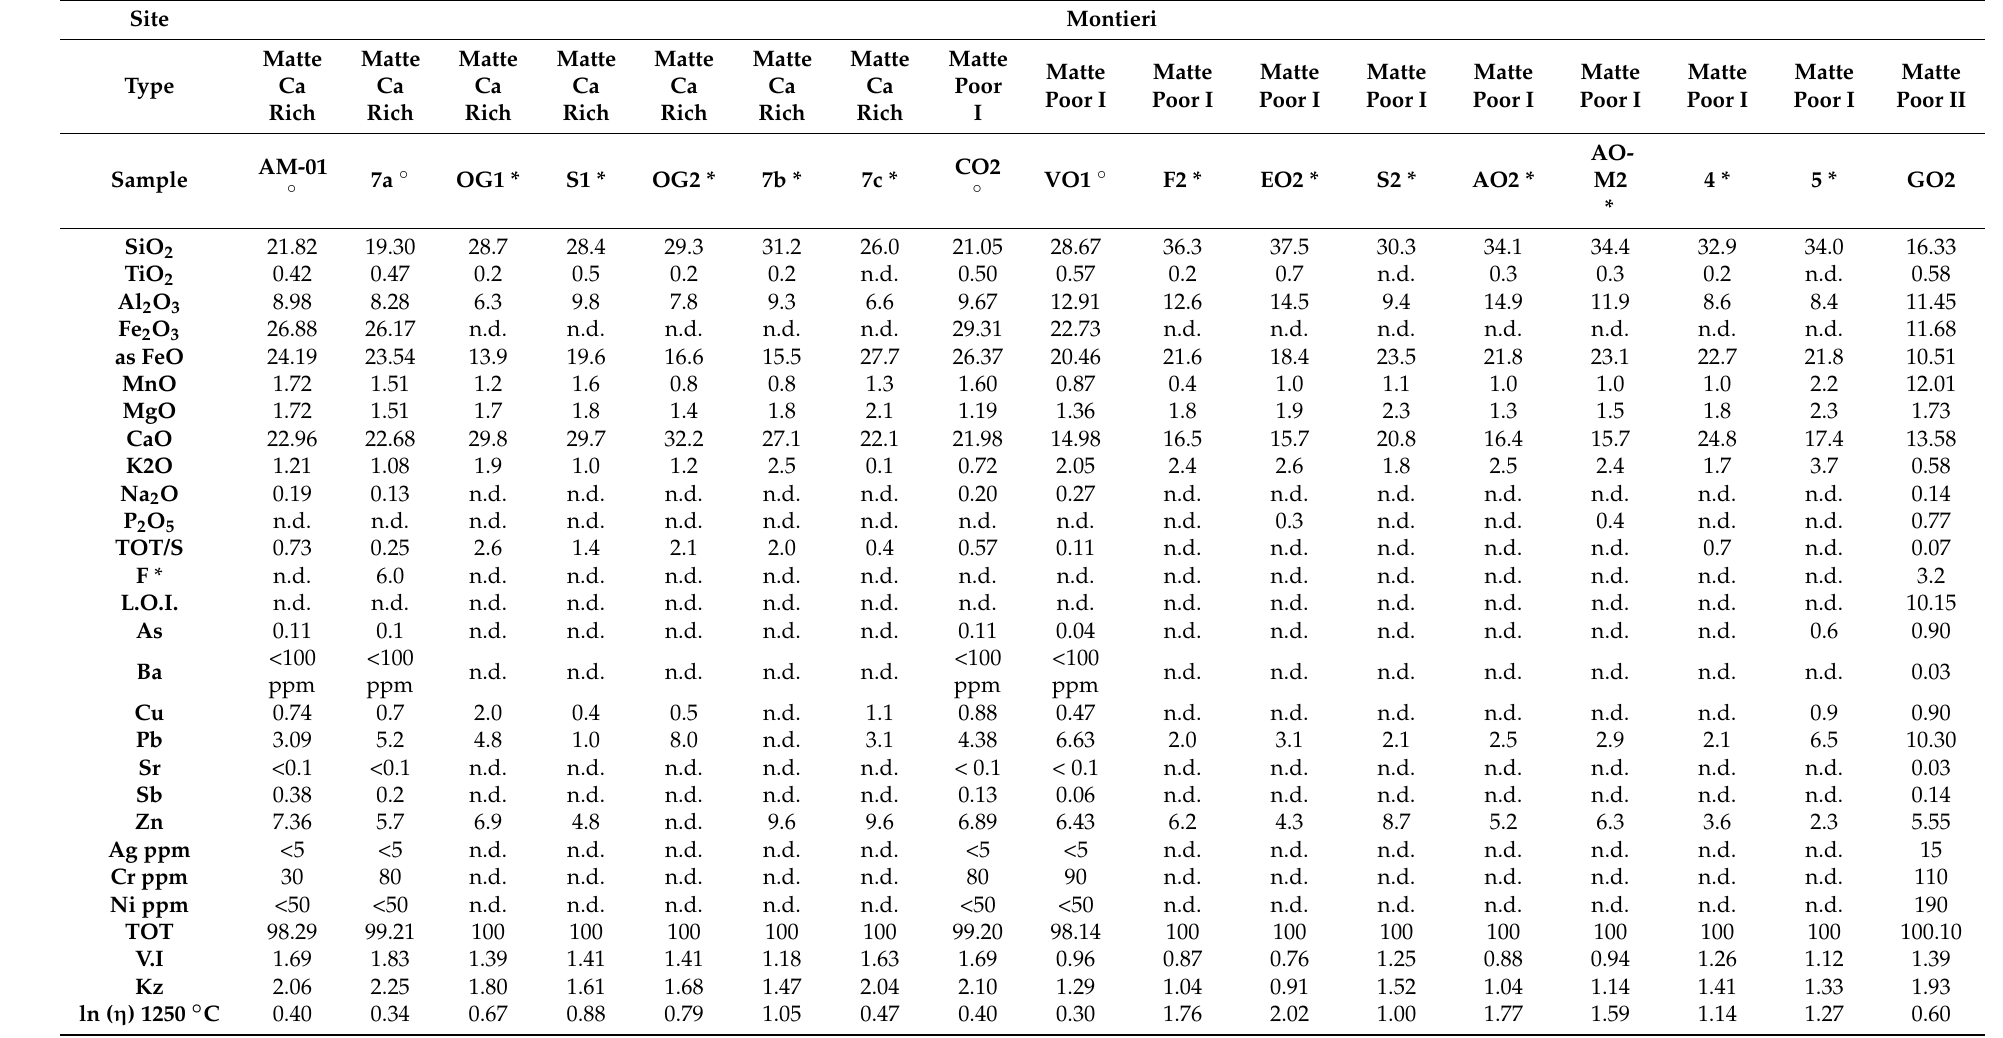
Table 3. Chemical composition of Matte Ca-rich and Matte Poor